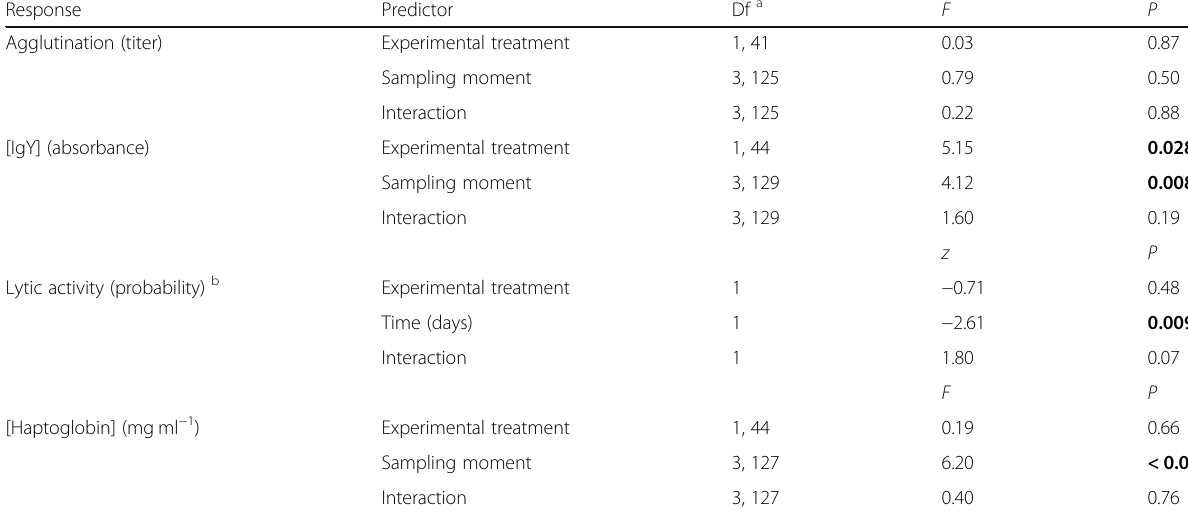
Table 1 Statistics of longitudinal analysis of experimental and temporal effects on innate immune function Response Predictor Df a Agglutination (titer)